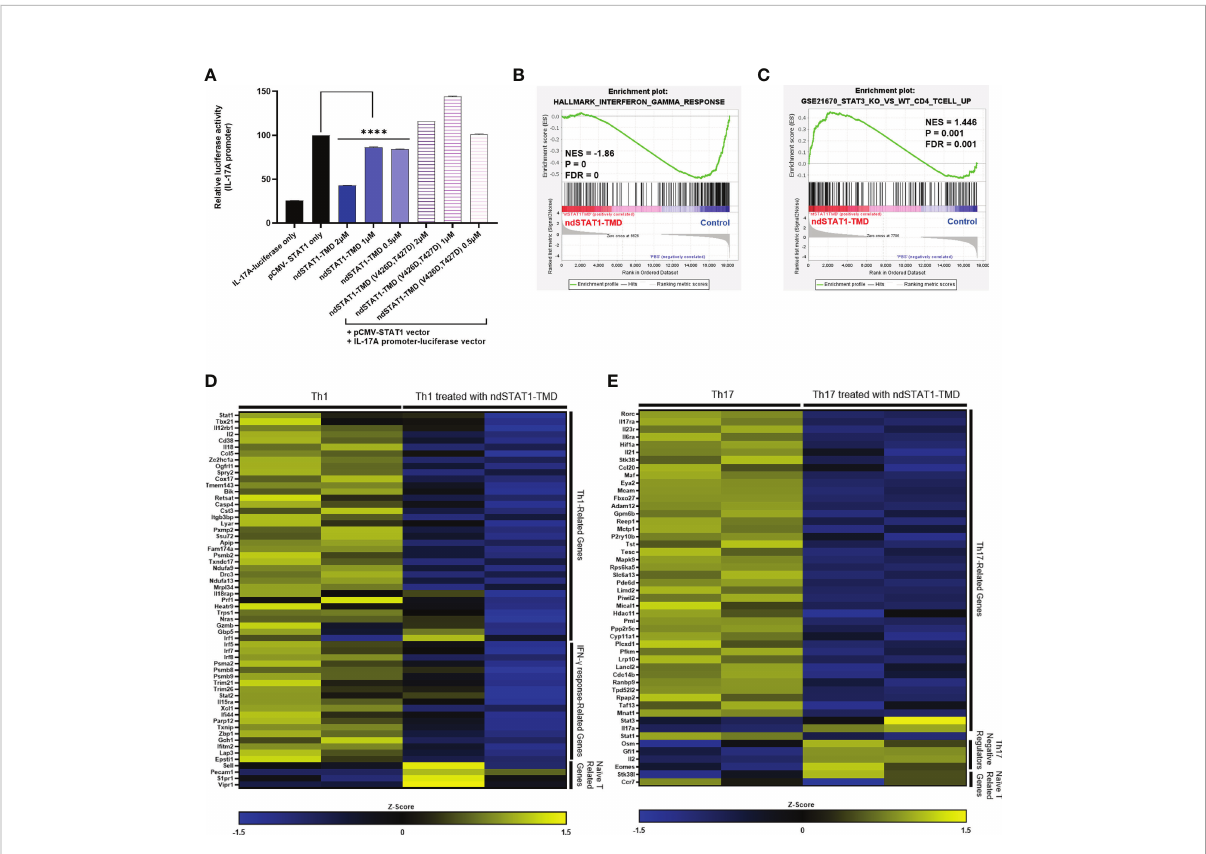
FIGURE 3 ndSTAT1-TMD inhibits the expression of STAT1-target genes at the transcription level. (A) HEK293T cells were co-transfected with the plasmids containing the luciferase reporter gene, whose expression is driven by the IL-17A promoter, and the wild-type STAT1 gene. The luciferase activity of cells was measured 24 hr after the treatment with ndSTAT1-TMD or ndSTAT1-TMD (V426D, T427D) by a luminometer. Data are represented as mean ± SEM (n=5), and statistical signi fi cance was indicated when the luciferase activity was lower than the positive control group (pCMV-STAT1-only). The statistical analysis was examined using Student ’ s t-test. ****p<0.0001. (B, C) GSEA-based enrichment plots of the hallmark of IFN- g response gene set in ndSTAT1-TMD-treated Th1 cells or of the gene set upregulated in STAT3 knockout CD4 + T cells compared to wild-type CD4 + T cells in ndSTAT1-TMD-treated Th17 cells. (D, E) Heatmap of Th1 or Th17 cell signature genes and naïve T cell- speci fi c genes in Th1 or Th17 cells treated with or without ndSTAT1-TMD. Each column means results from one experimental well Z-score was calculated from